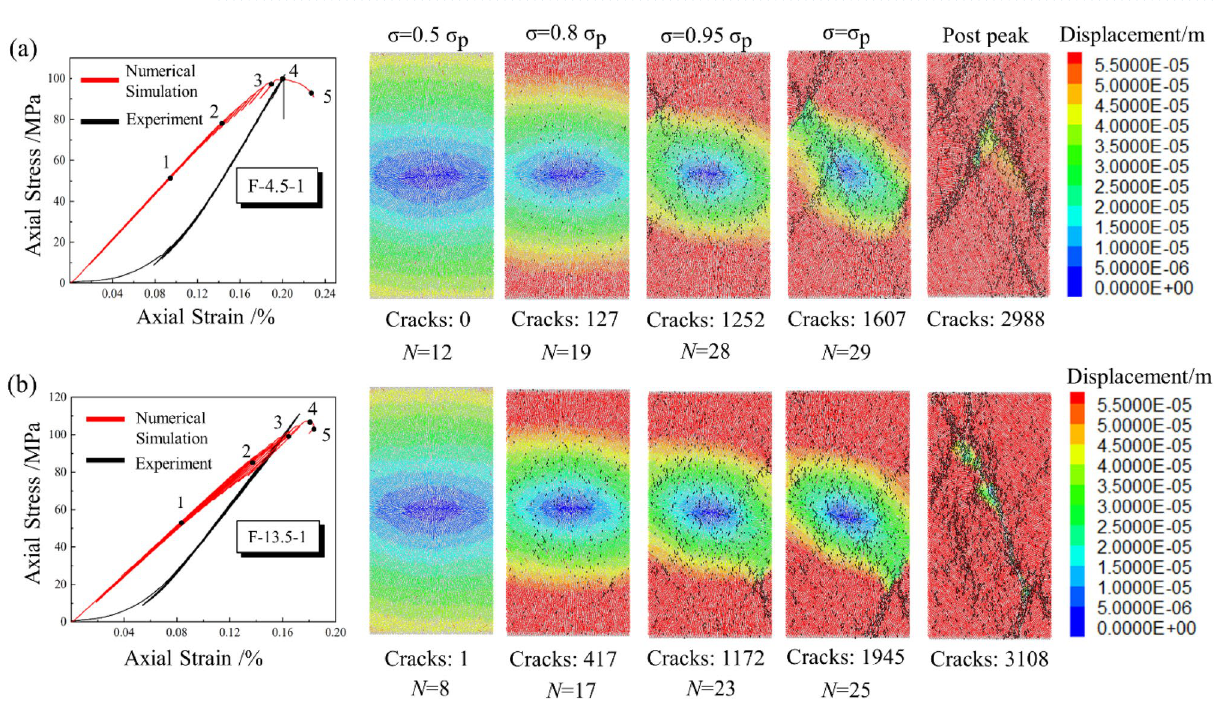
Figure 8. Comparison between experiment and simulation results. ( a ) Peak strength; ( b ) Dynamic elastic modulus.